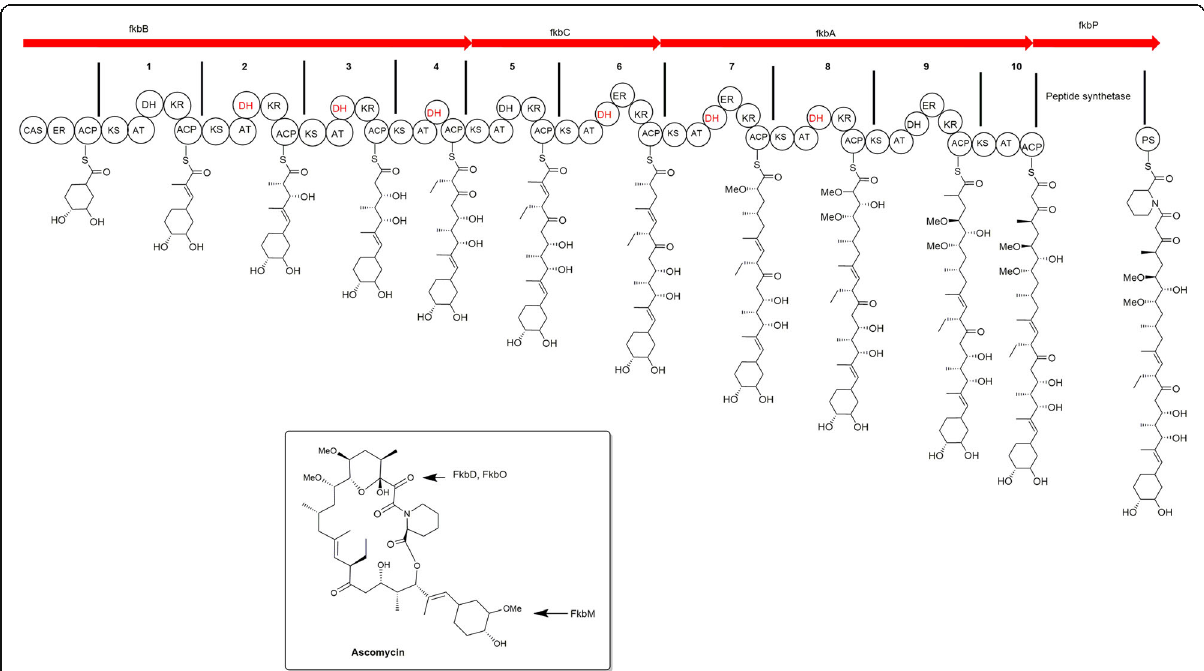
Fig. 2 Biosynthesis of FK520 by schematic representation of the PKS complex with circles representing the catalytic domains